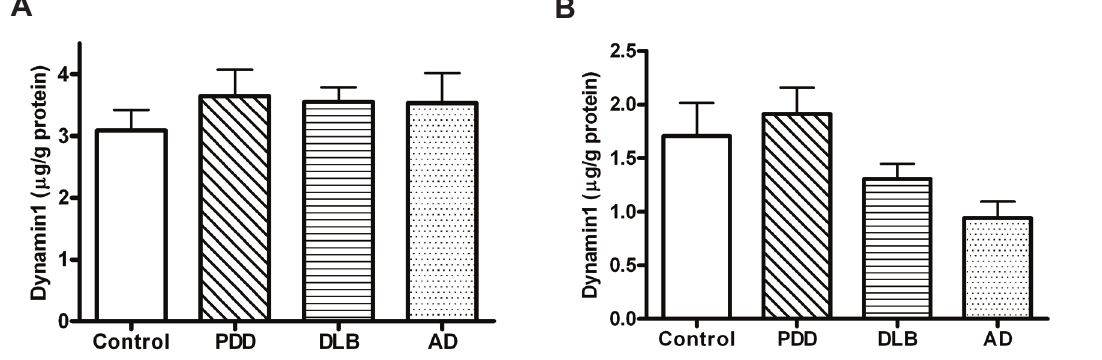
Figure 1. Concentration of Dynamin1 in BA9 and BA24 tissues by ELISA from subjects with PDD, DLB, AD and controls. ( A ) BA9, ( B ) BA24, PDD: Parkinson’s Disease Dementia; DLB: Dementia with Lewy Body; AD: Alzheimer’s Disease. Bars represent mean and error bars